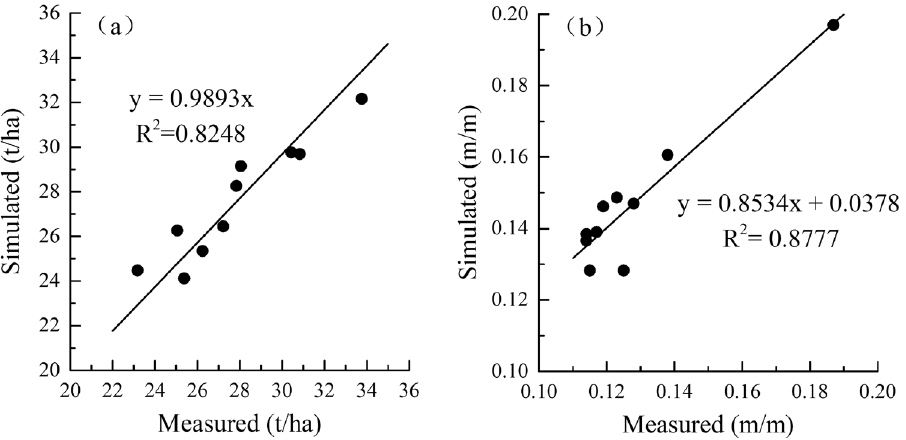
Figure 7. Simulated and measured yield ( a ) and soil moisture ( b ) in the rainfed apple orchards of